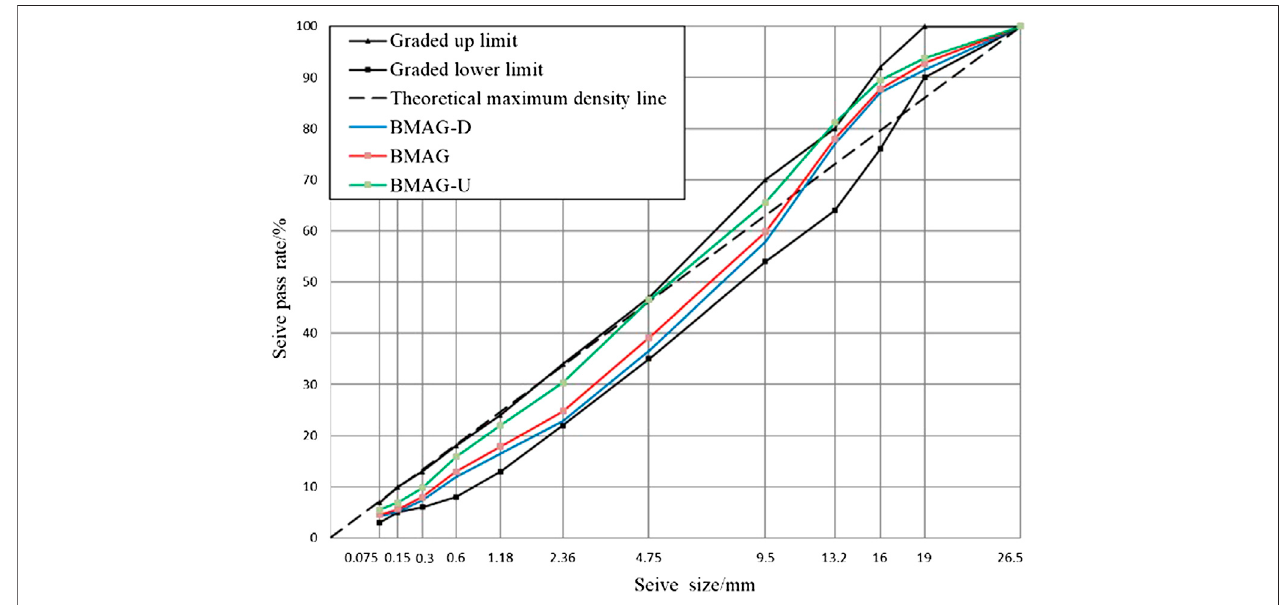
FIGURE 6 | Gradation curves of coarse aggregate and fi ne material variability.